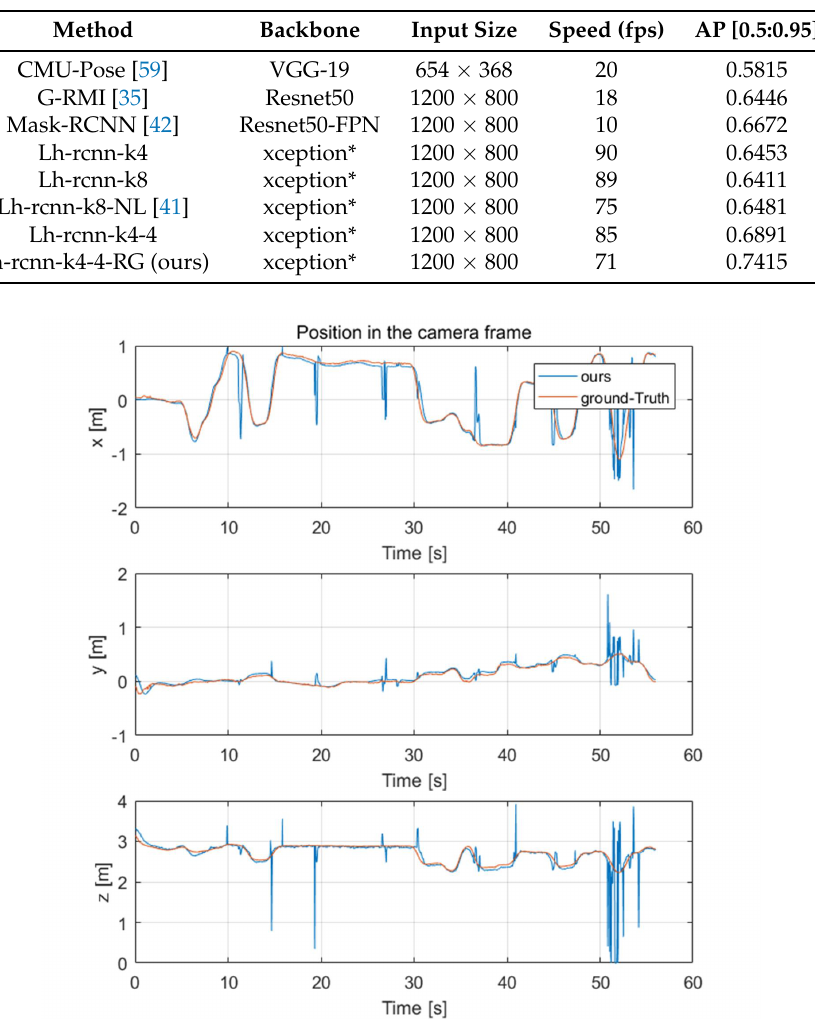
Figure 7. The position estimation in the camera frame, compared with OptiTrack (as